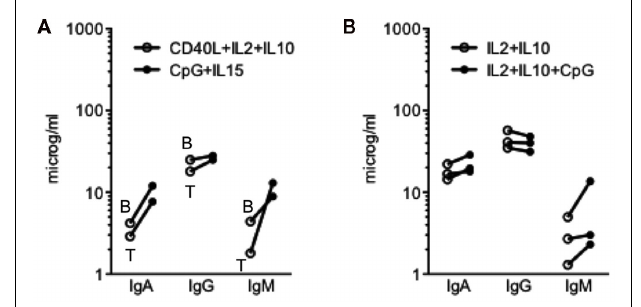
FIGURE 4 | (A) Ig secretion of CD27 + B-cells cultured with CD40L plus IL2 and IL10 or with CpG ODN plus IL15. CD27 + B-cells from tonsil (T) or peripheral blood B were cultured as described in the legend of Figure 1 . Supernatants were collected at Day 10, and Ig secretion was assessed by ELISA. (B) Ig secretion of CD40L-generated prePBs cultured with or without CpG ODN. PrePBs generated in the CD40L culture were obtained as described in Figure 2B and cultured for 3days with or without CpG in the presence of IL2 + IL10. Supernatants were collected at Day 7, and Ig secretion was assessed by ELISA.Three independent experiments were performed with two